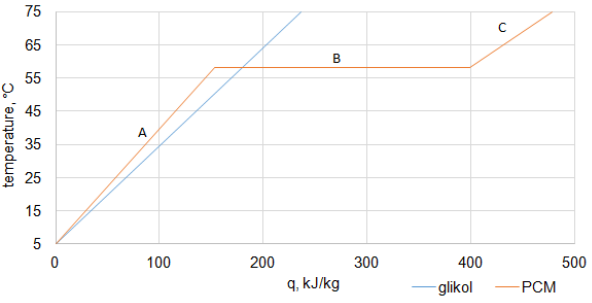
Fig. 2. Latent heat and sensible heat capacity (A – charging solid PCM; B – melting; C – charging liquid